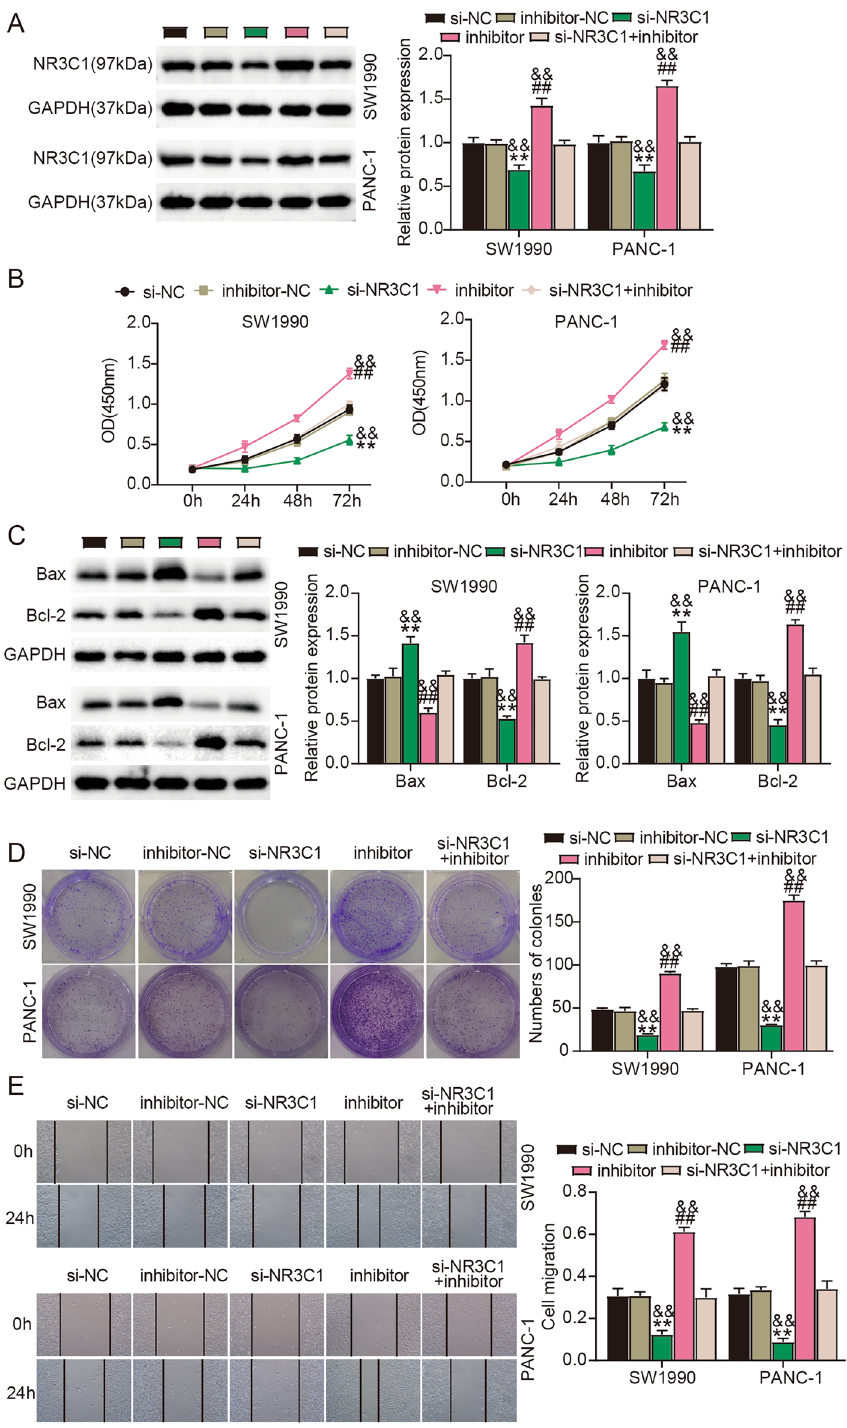
Figure 7. MiR-1270 inhibition reversed the cancer-suppressive effects of NR3C1 knockdown in PC cells. ( A – E ) Rescue experiments were conducted in SW1990 and PANC-1 cells with si-NC, inhibitor-NC, si-NR3C1, inhibitor or si- NR3C1 + inhibitor transfection. ( A ) NR3C1 protein expression in these cells was checked by western blotting. ( B ) Cell proliferation was evaluated by CCK-8 assay. ( C ) Expression of Bax and Bcl-2 was measured by western blotting to assess cell apoptosis. ( D ) Cell clone formation ability was evaluated by colony formation assay. ( E ) Cell migration was evaluated by wound healing assay. ** P < 0.001 relative to si-NC; ## P < 0.001 relative to inhibitor-NC; && P < 0.001 relative to si-NR3C1 +